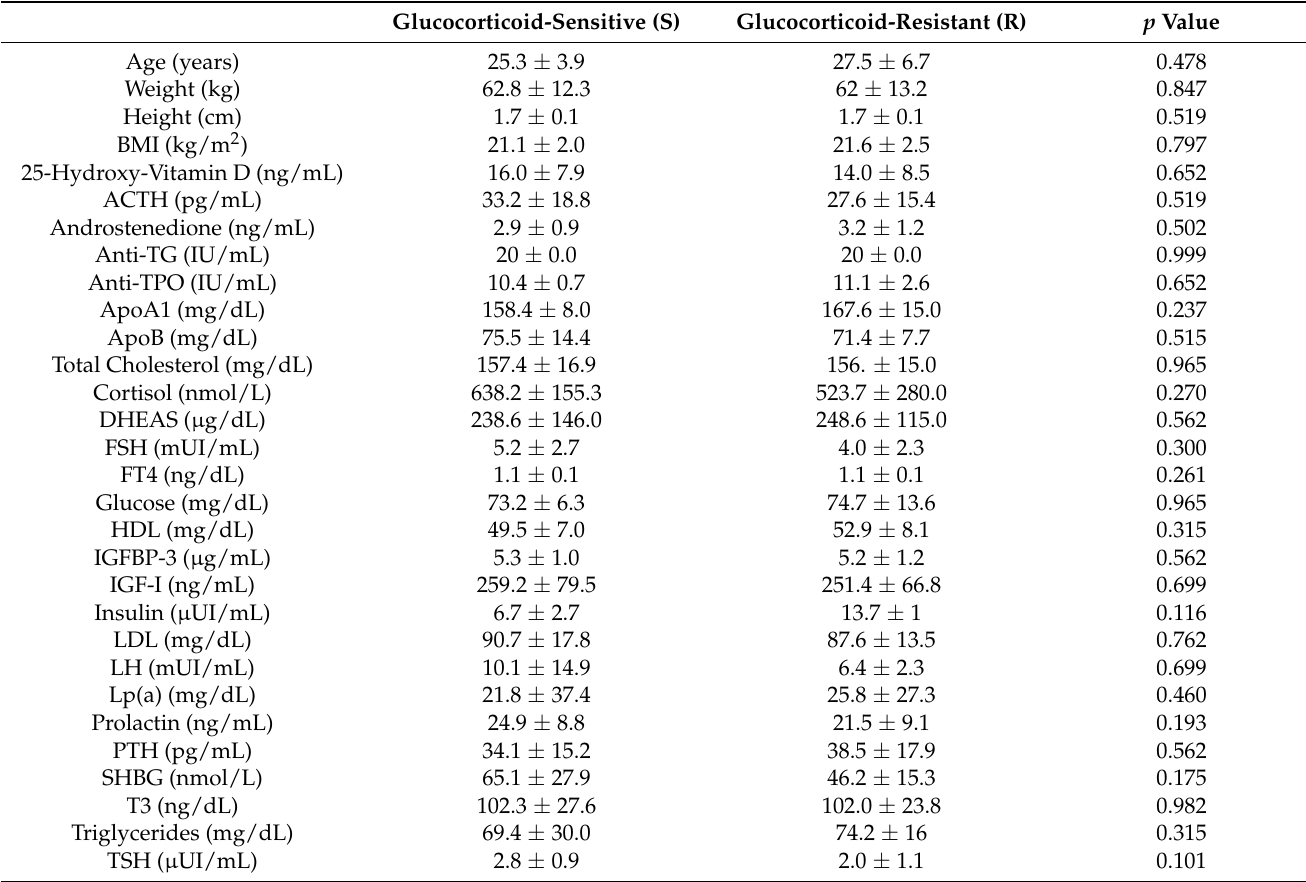
Table 2. Clinical characteristics, biochemical and endocrinologic parameters of the most glucocorticoid-sensitive (S) and most glucocorticoid-resistant (R) healthy subjects one month after the very-low dexamethasone suppression